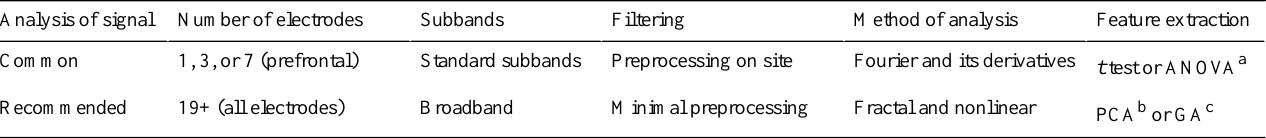
Table 2. Summary of the abovementioned comparisons of analysis of signals in the